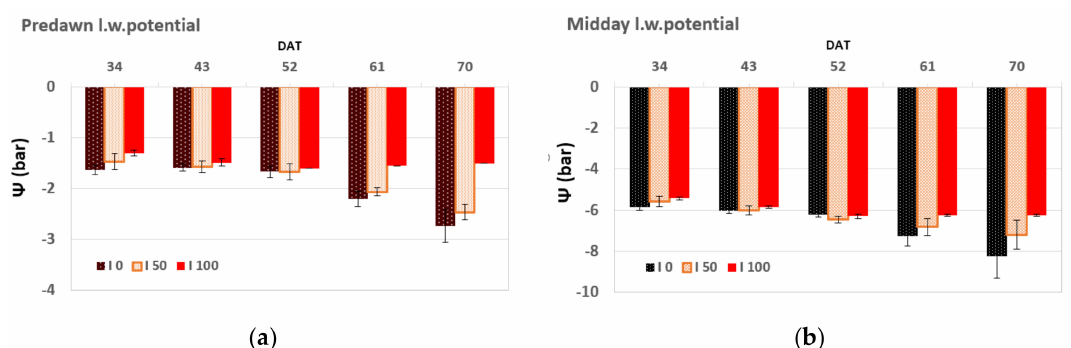
Figure2. ( a )Predawnand( b )middaywaterpotentialsoffullyirrigated(I 100 ), moderatelywater-stressed (I 50 ) and severely water-stressed (I 0 ) spearmint plants along the growth cycle. Values are means ± 1